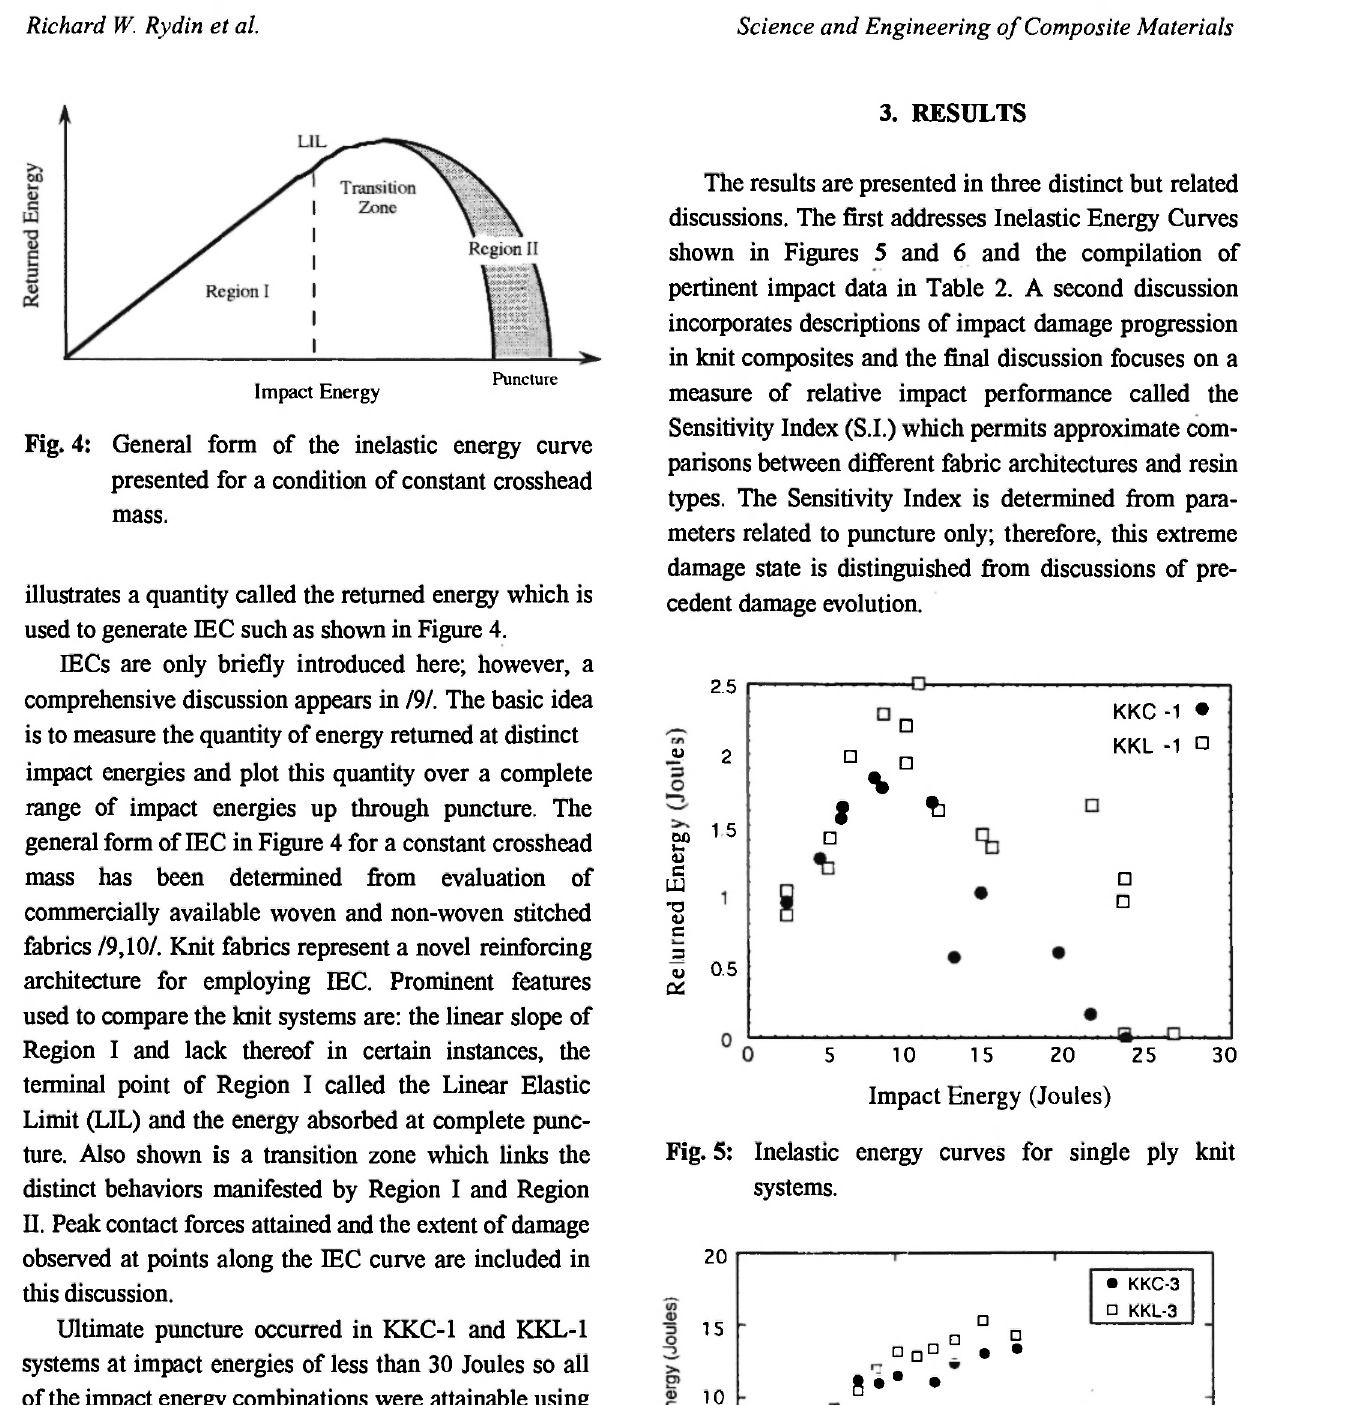
Fig. 6: Inelastic energy curves for triple play knit